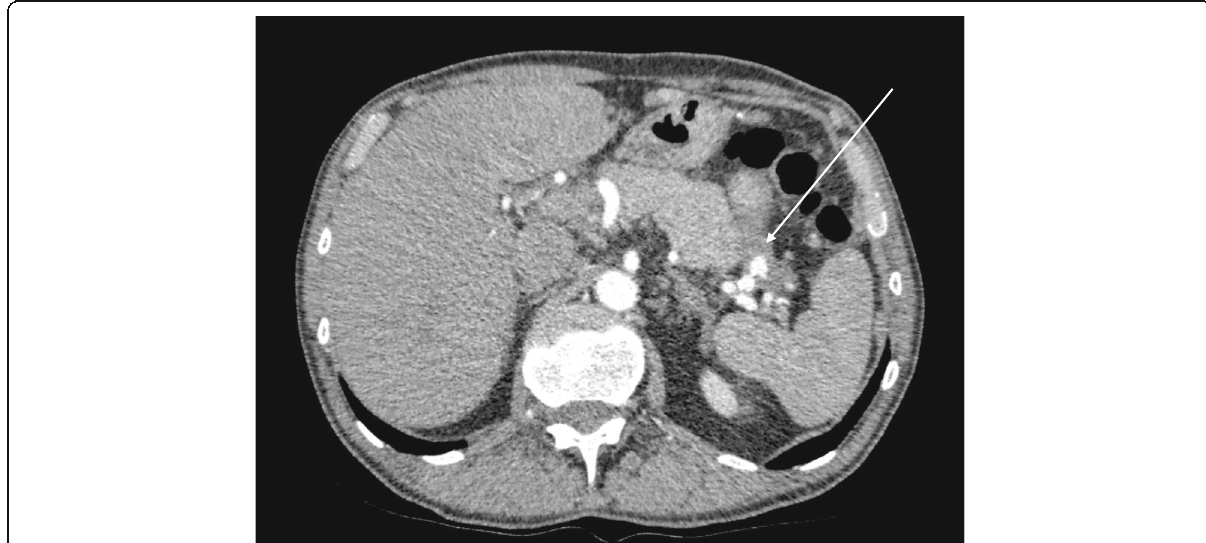
Fig. 1 Pseudoaneurysm of the splenic